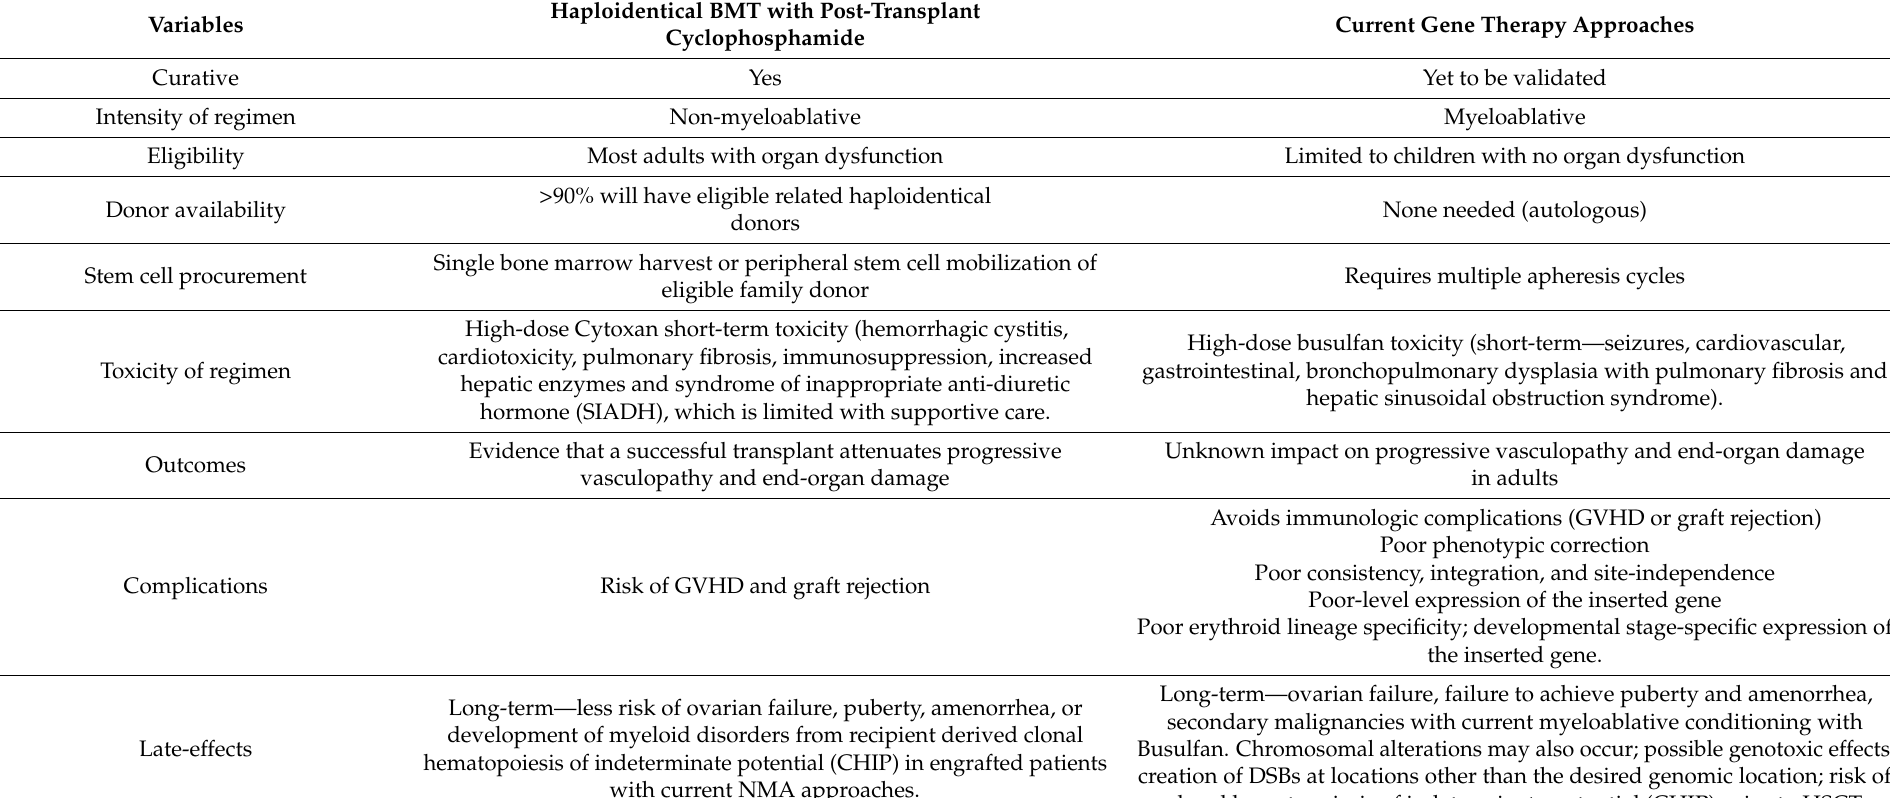
Table 2. Comparison of the two curative therapies for adults with severe